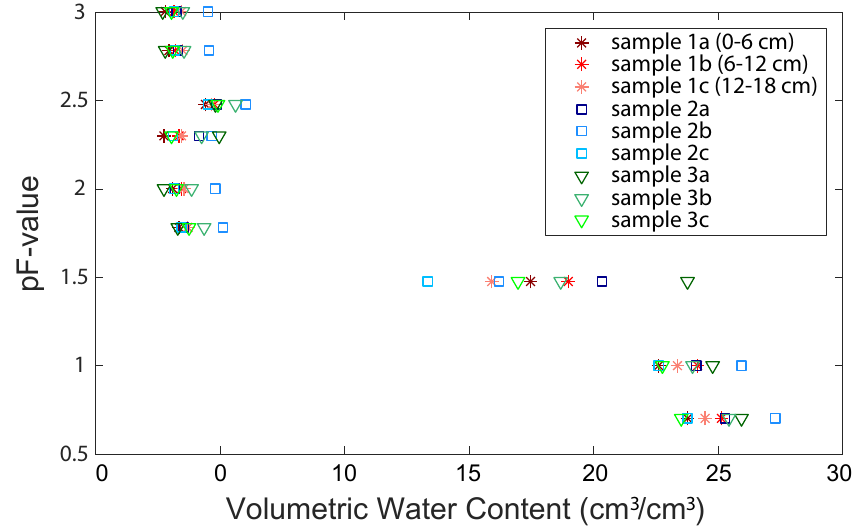
Figure 2. pF curves of the soil at Egmond Beach, made with nine samples. All samples with number 1 were taken at the same location in the swash zone, samples with number 2 were taken at the same location on the intertidal beach and samples with the number 3 were taken at the same location near the dune foot. The letters a, b and c mean ∼ 0–6 cm, ∼ 10–16 cm and ∼ 20–26 cm depth,